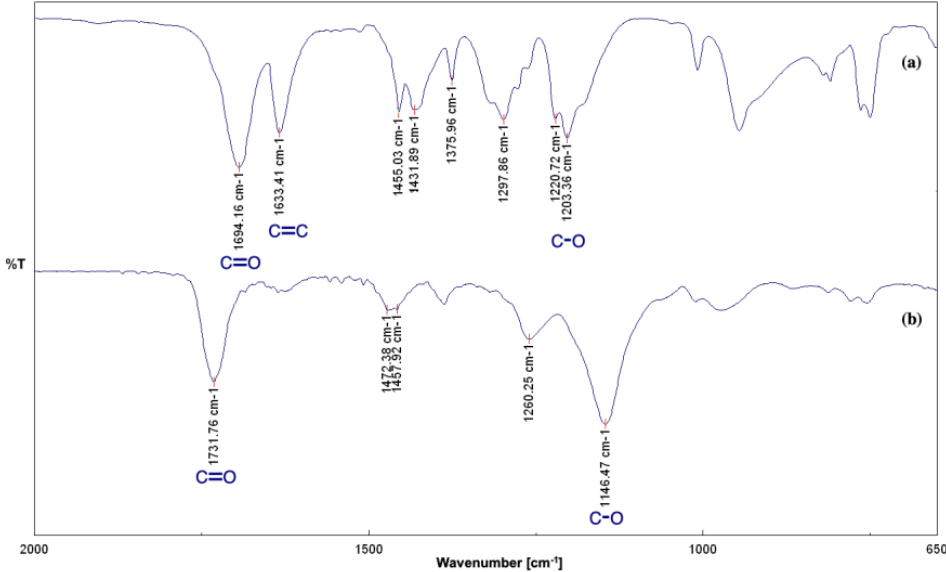
Figure 3. SEM image of RAC-MIP (3000× magnification). Synthesized MIPs were also analyzed by FTIR analysis (Figure 4).